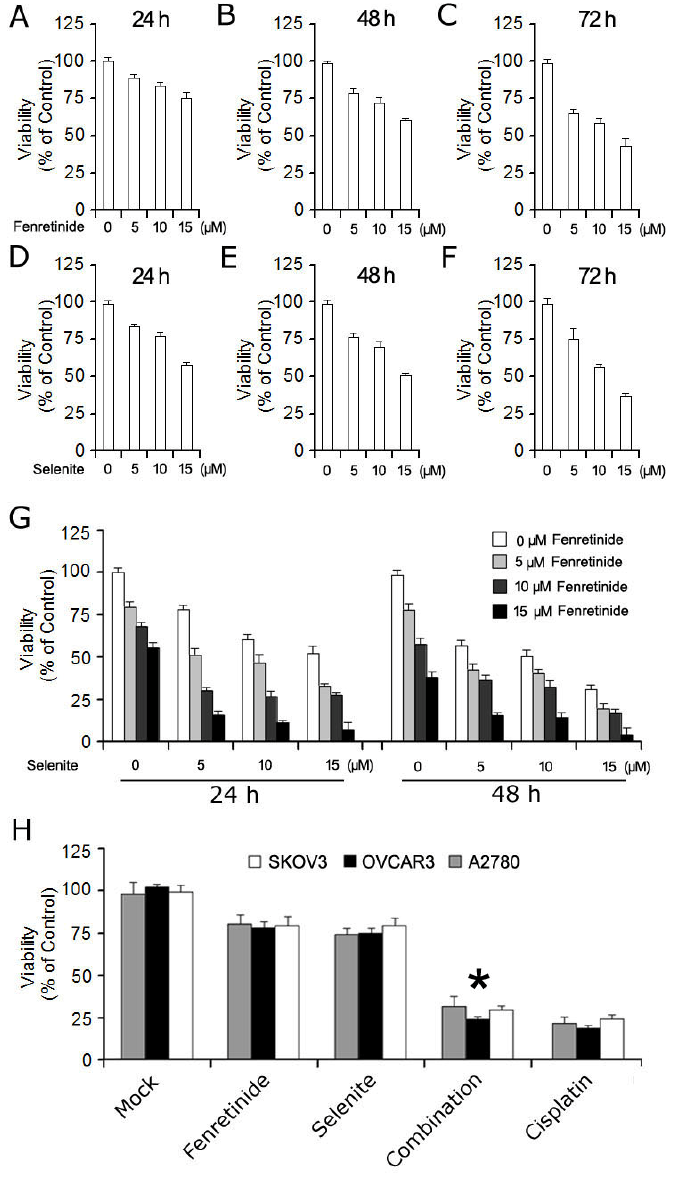
Figure 1. Effect of fenretinide and selenite on ovarian cancer cells proliferation. Viability of SKOV3 cells was measured by MTT after exposure of fenretinide with different concentrations for 24 h ( A ); 48 h ( B ) and 72 h ( C ); Viability of SKOV3 cells measurement after exposure of selenite with different concentration for 24 h ( D ); 48 h ( E ) and 72 h ( F ); SKOV3 cells’ viability under different concentration of fenretinide and selenite combination treated for 24 h and 48 h ( G ); Viability assay using two additional different ovarian cell lines (OVCAR3 and A2780) after exposure of drugs alone (10 µmol/L fenretinide, 10 µmol/L selenite) or drug combination (10 µmol/L fenretinide plus 10 µmol/L selenite) for 48 h, 10 µg/mL cisplatin treatment used as positive control ( H ). (means ± s.d., * p <